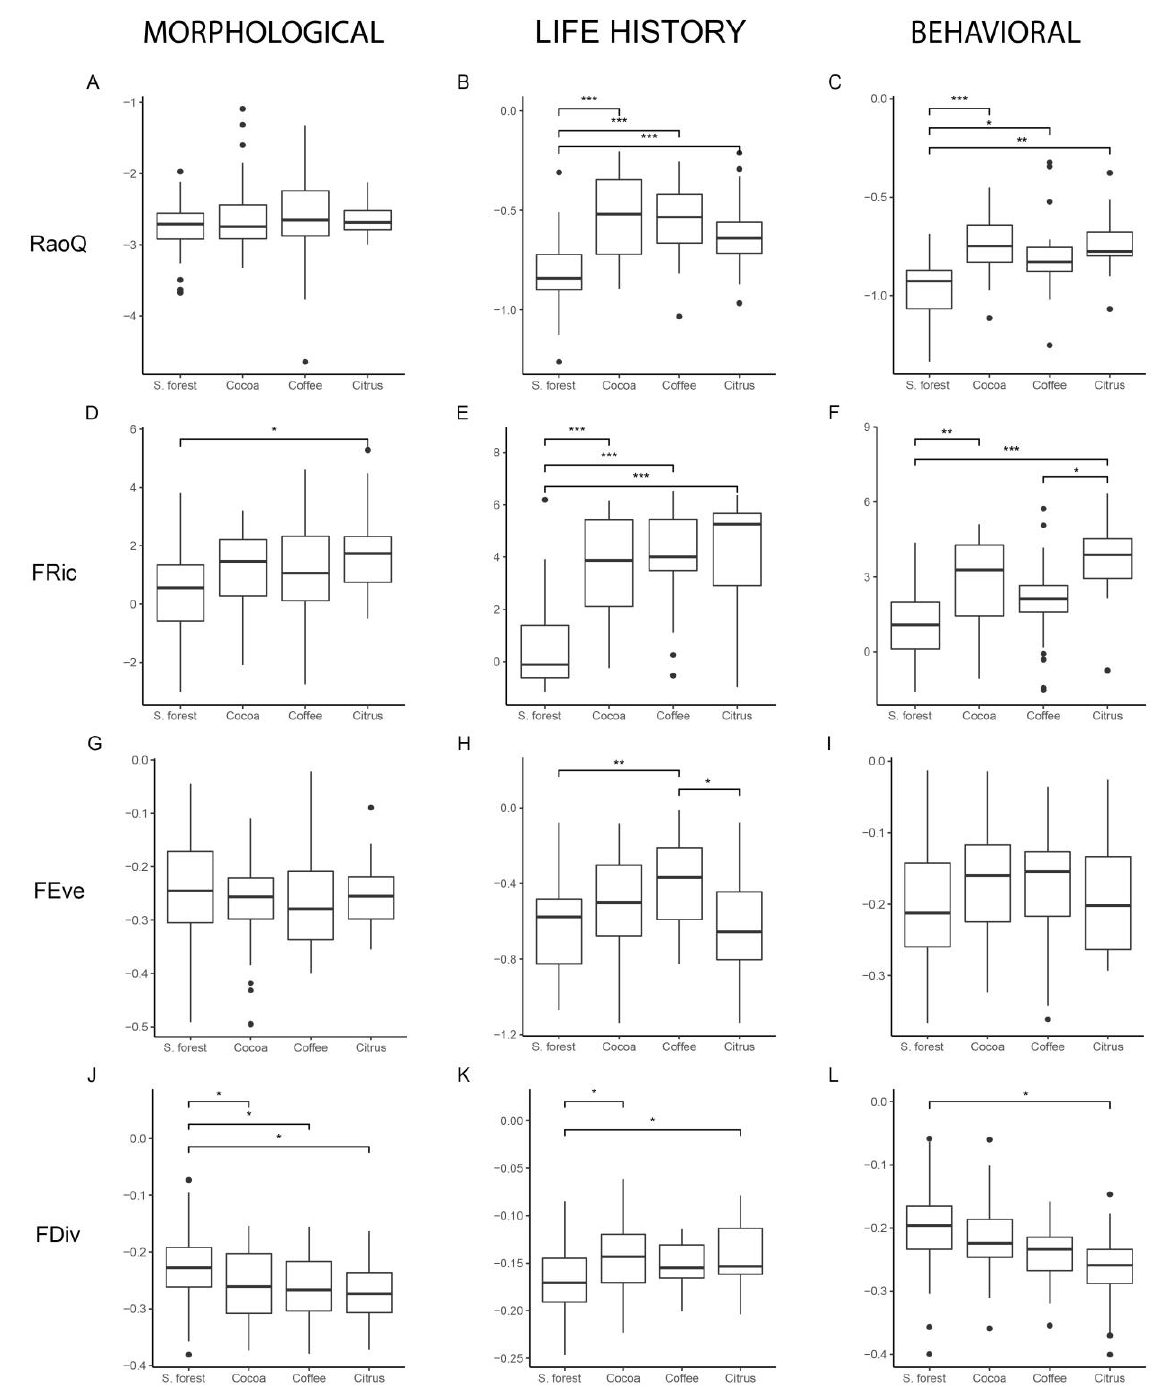
Figure 1. Functional diversity of bird morphological (panels A , D , G , J ), life history ( B , E , H , K ), and behavioral (panels C , F , I , L ) traits among agroecosystems and secondary forests using four functional diversity indices: RaoQ (panels A – C ), FRic (panels D – F ), FEve (panels G – I ), and FDiv (panels J – L ). Dots outside boxplots represent outlier values. Significant differences are denoted with asterisks (* p < 0.05; ** p < 0.01; *** p < 0.001).